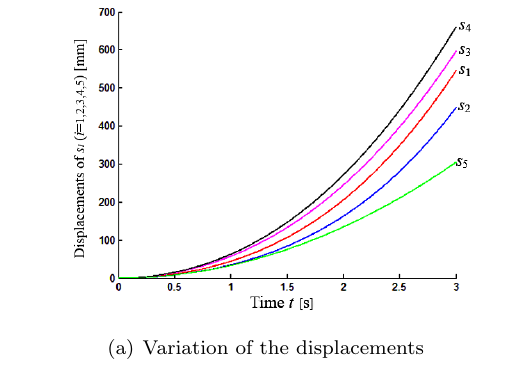
Table 5: The range of motion of the MP Description Value The range of z -displacement 0.131m, 0.133m] The maximum and minimum displacements along x direction at z 0.357m, 0.787m 1.684 z m.